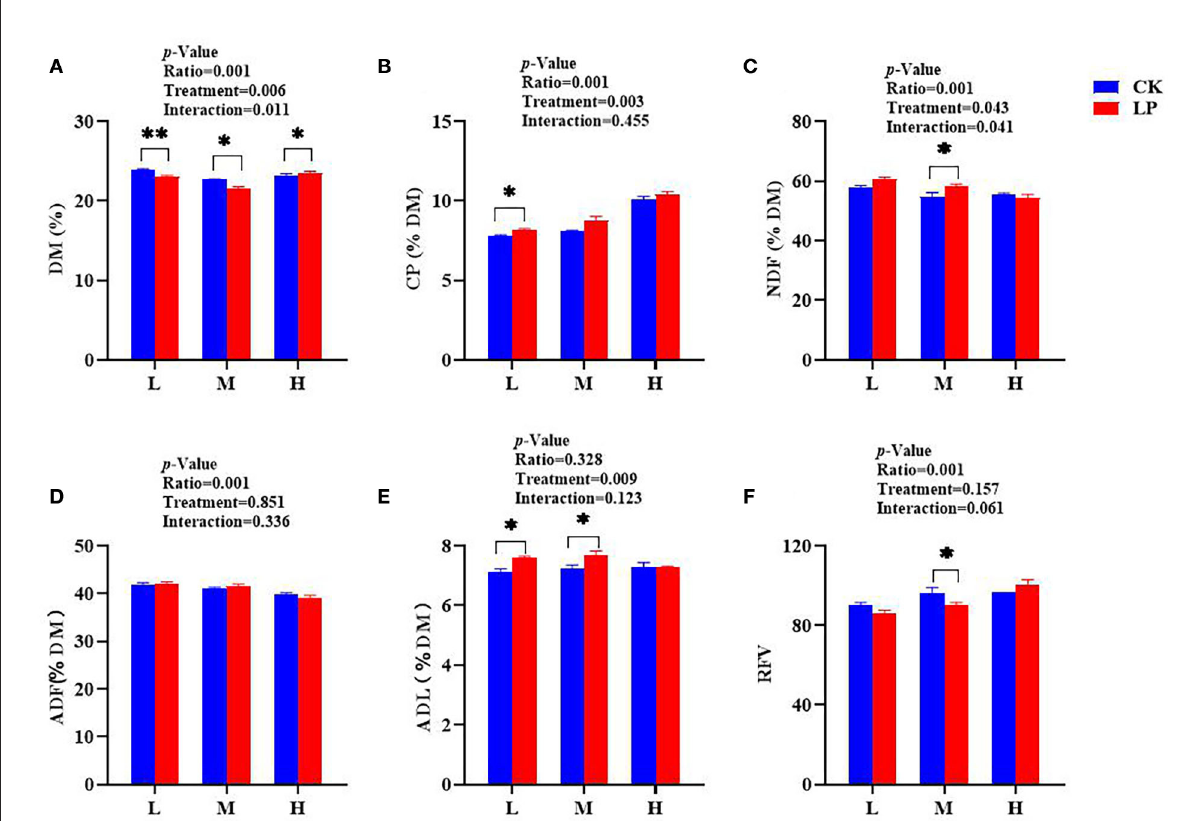
FIGURE2 Chemical characteristics of Lablab and sweet sorghum intercropped silages with or without LP after fermentation. (A) for DM, (B) for CP, (C) for NDF, (D) for ADF, (E) for ADL, and (F) for RFV. DM, dry matter; CP, crude protein; NDF, neutral detergent fiber; ADF, acid detergent fiber; ADL, acid detergent lignin. RFV, relative feed value. CK, sterile water; LP, Lactobacillus plantarum ; L, Lablab and sweet sorghum seed-sowing ratio of 1:1; M, Lablab and sweet sorghum seed-sowing ratio of 5:1; and H, Lablab and sweet sorghum seed-sowing ratio of 9:1. “*” and “**” represent the significance at 0.05 and 0.01,